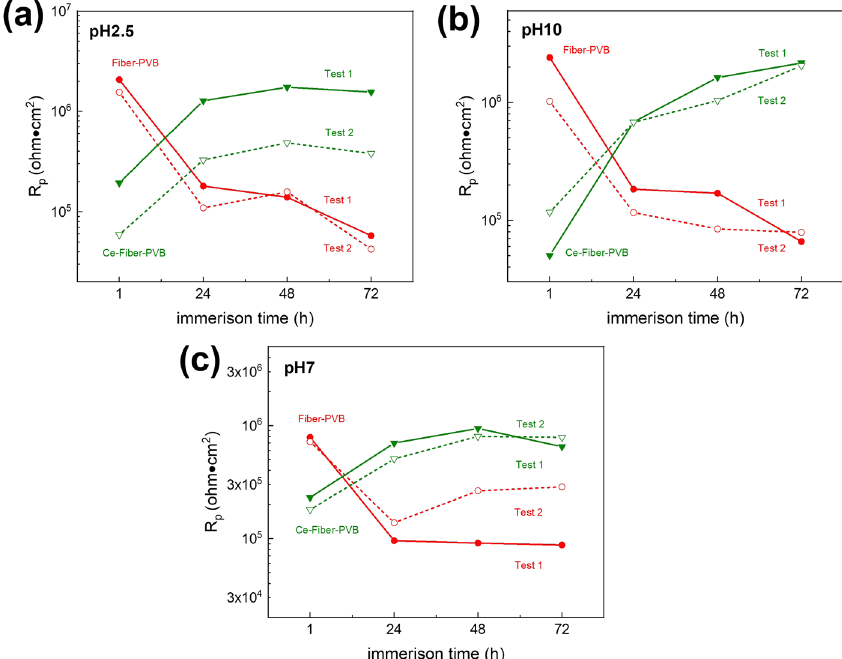
Fig. 6 Evolution of R p of Fiber-PVB and Ce-Fiber-PVB at different pH conditions. Coated samples were immersed in 5 mM Na 2 SO 4 with pH a 2.5, b 10, c